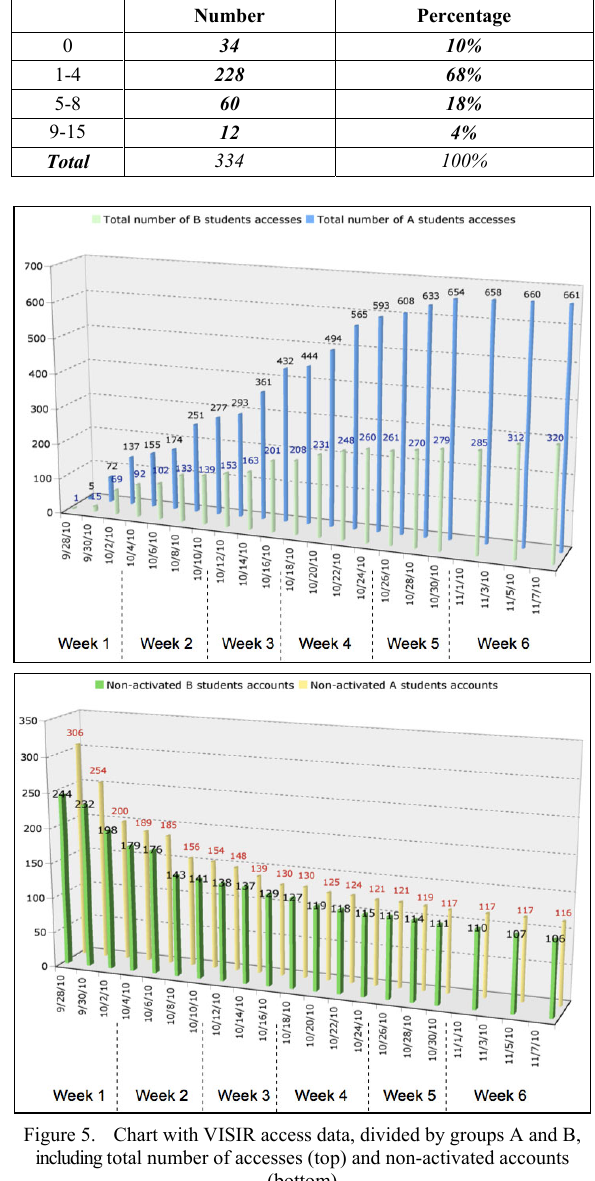
Figure 5. Chart with VISIR access data, divided by groups A and B, including total number of accesses (top) and non-activated accounts